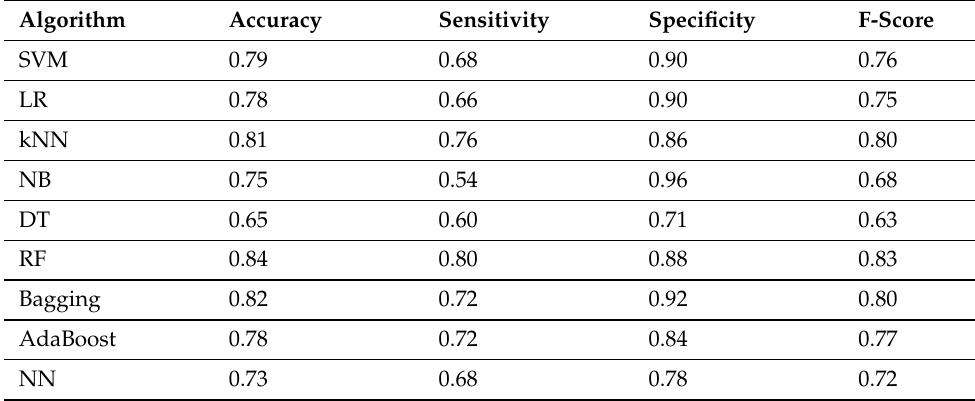
Figure 6. Correlation coefficient between feature and diagnosis. Table 6. Results using first 9 features ranked using